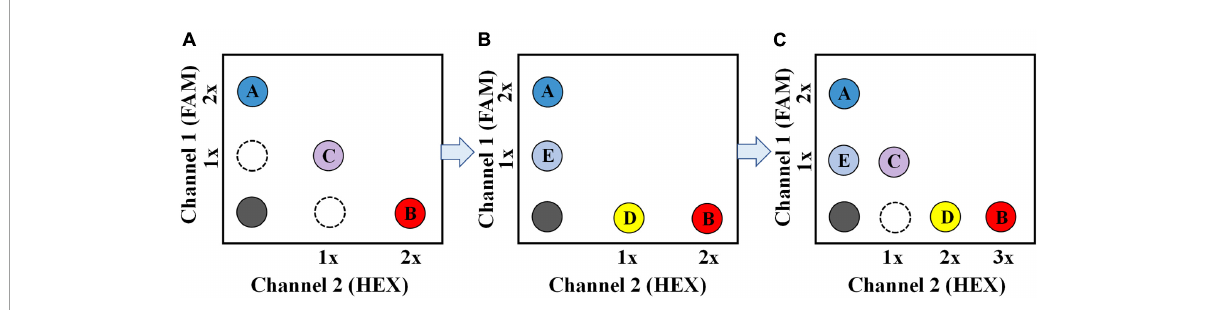
FIGURE1 Schematic description of the multiplex ddPCR assay for simultaneous detection of three targets (A) , four targets (B) , and five targets (C) , respectively. For the 5-plex ddPCR assay, target A and B are recognized by a FAM -labeled (2 × conc.) and a HEX-labeled probe (3 × conc.), respectively; Target C is recognized by a FAM-labeled (1 × conc.) probe and a HEX-labeled probe (1 × conc.) simultaneously; target D and E are recognized by a HEX-labeled (2 × conc.) and a FAM-labeled probe (1 × conc.), respectively.